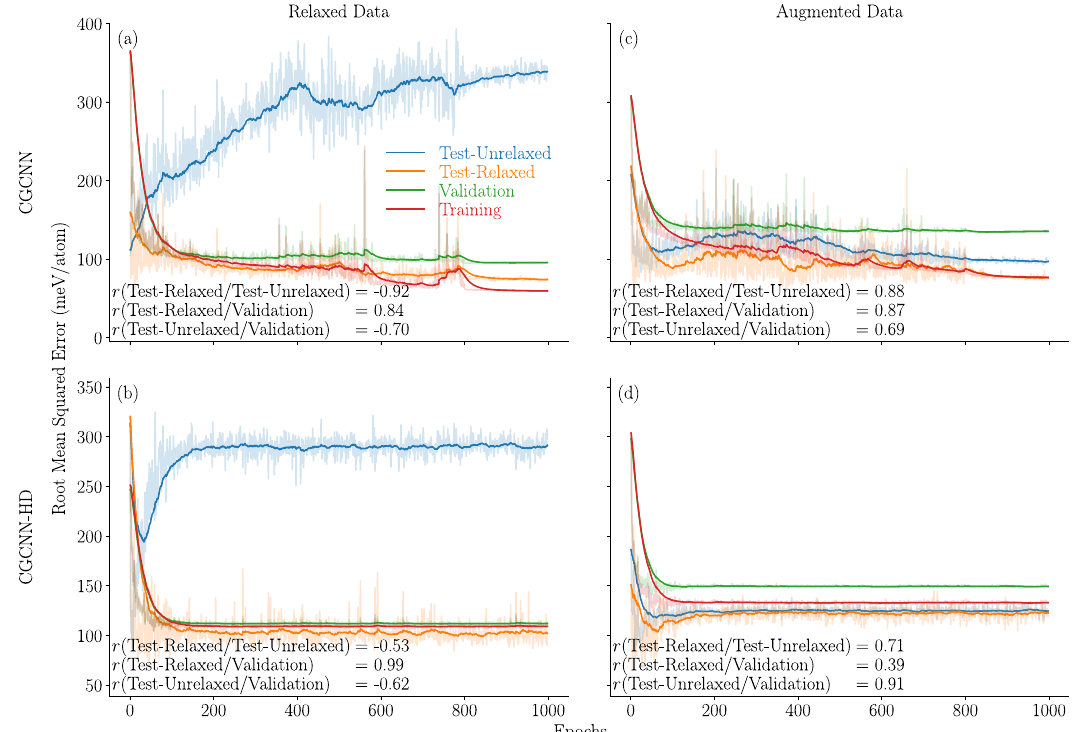
Fig. 2 Learning curves. a The CGCNN trained on relaxed data, b the CGCNN-HD trained on relaxed data, c the CGCNN trained on augmented data, d the CGCNN-HD trained on augmented data on the relaxed (1st column) and augmented (2nd column) data. The faded curves show the exact loss values, while the solid curves show the smoothed values. The red and green curves denote the loss on the training and validation data, respectively. The orange and blue curves display the loss for the Test-Relaxed and Test-Unrelaxed test sets, respectively. Note that the Test-Relaxed and Test-Unrelaxed datasets were not used in the training or validation of the model. The r values are the Pearson correlation coef fi cients between the stated